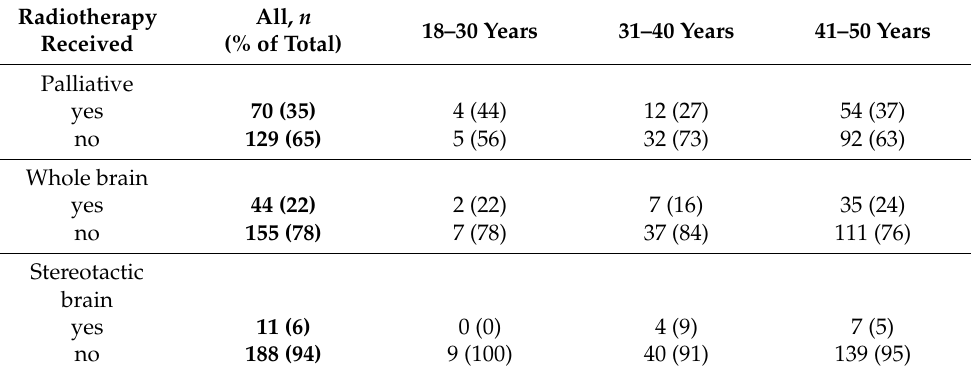
Table 3. Radiotherapy treatment in all metastatic NSCLC patients ( n = 199) by age